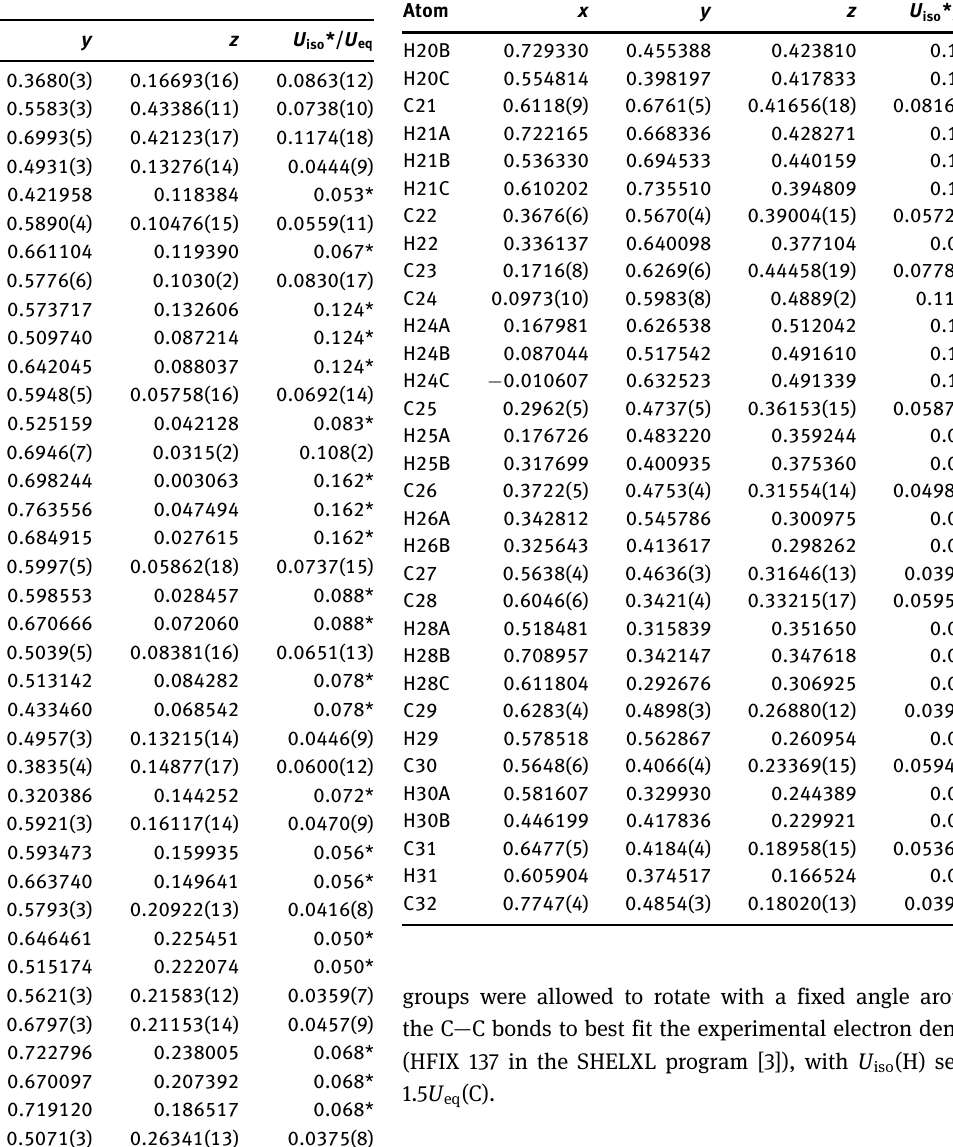
Table 2: Fractional atomic coordinates and isotropic or equivalent isotropic displacement parameters (Å 2